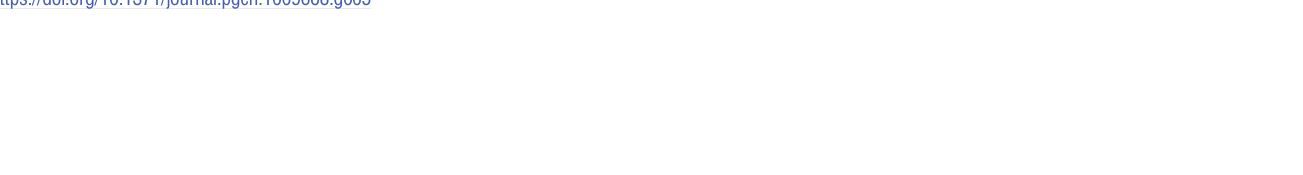
Fig 5. SAGA footprint at different promoter types in cells. ( A) Average footprints of SAGA subunits in reads per million (RPM) (left to right TATA, DPE TCT, HK). From top to bottom TBP and TRF2, SAGA subunits WDA, Spt3, SAF6 and Ada2b. (B) SAGA levels are overall similar across promoter types.